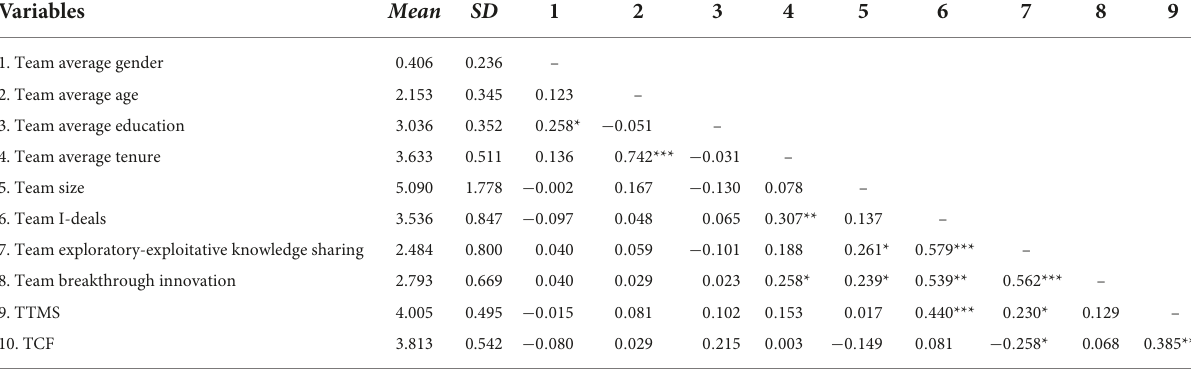
TABLE 1 Means, standard deviations, and correlation matrix for key measures. Variables